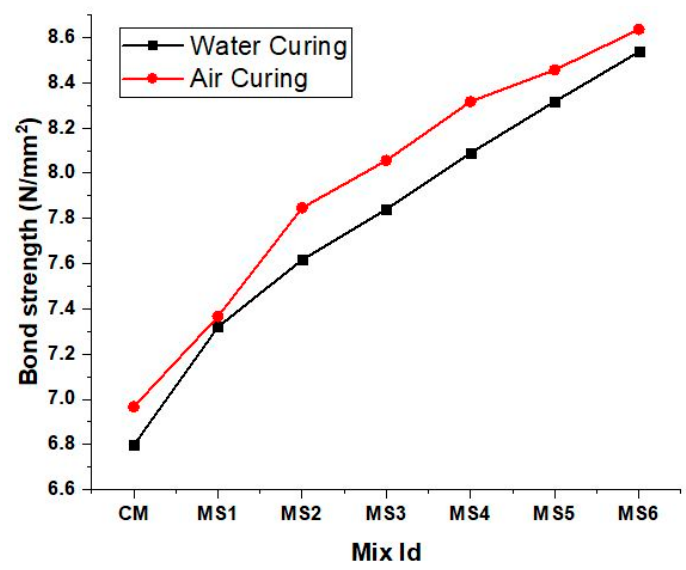
Figure 8. Bond strength of the concrete mixes in air and water curing.